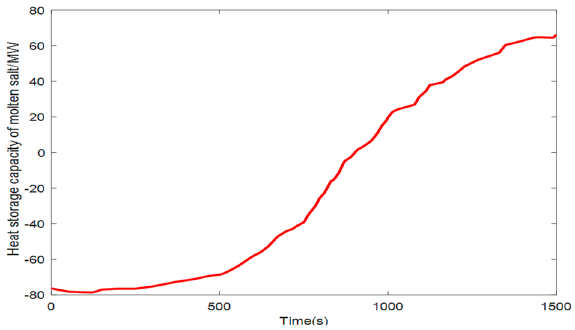
Figure 7. Molten salt storage capacity.